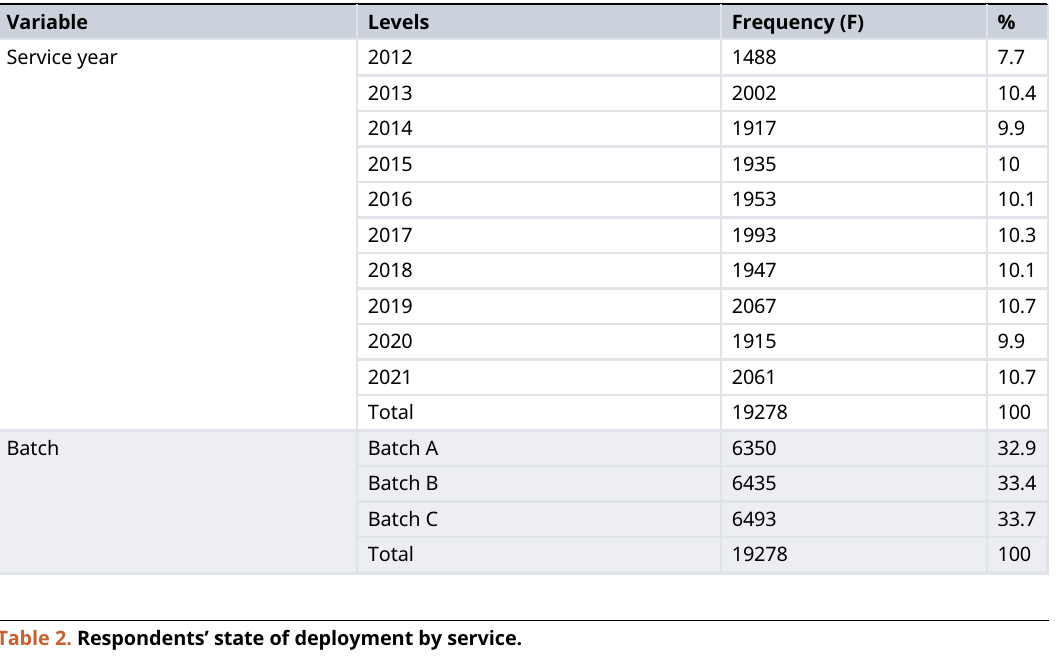
Table 2. Respondents ’ state of deployment by